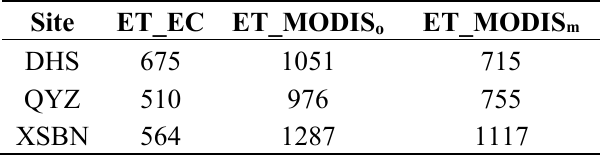
Table 4. Comparison between flux-derived ET (ET_EC), the original MODIS-derived ET (ET_MODIS o ) and modeled ET using the MODIS ET algorithm and meteorological data measured in subtropical and tropical forests (ET_MODIS m